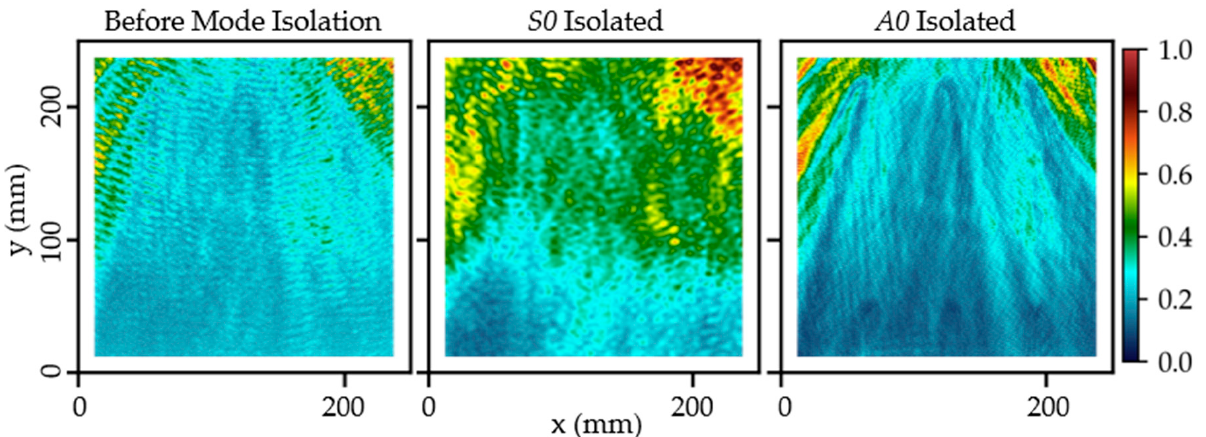
Figure 11. Spectral energy maps of Case D3, processed from unfiltered ( left ), S0 -isolated ( middle ), and A0 -isolated data ( right ). The uneven distribution of energy was unavoidable due to the anisotropic wave behaviour caused by the honeycomb cells.